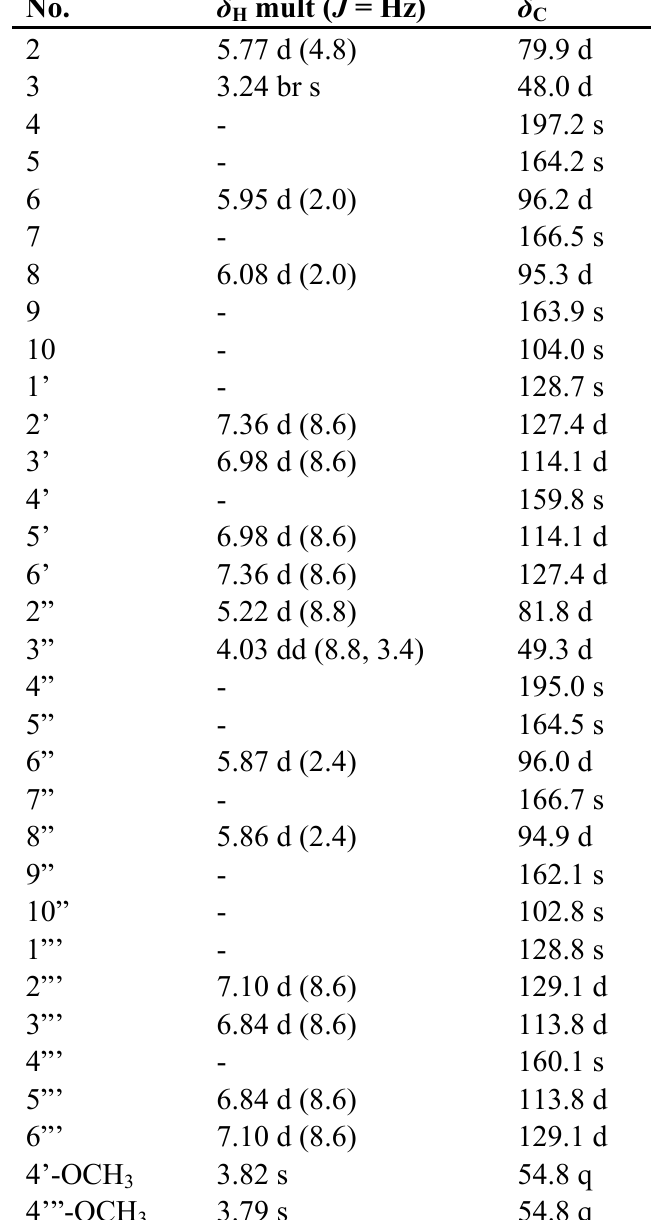
(500 MHz for 1 H, 125 MHz for 13 C). 6